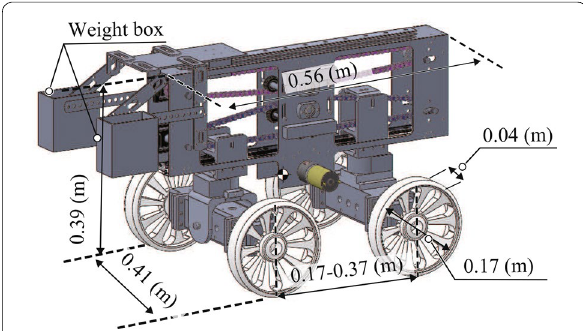
Fig. 1 Schematic view of the testbed rover with function of push-pull locomotion